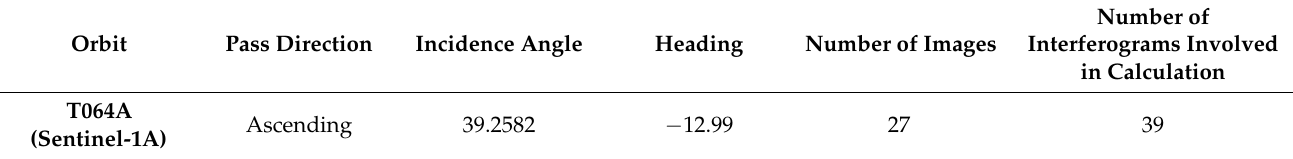
Table 3. Details of selected aftershock interference